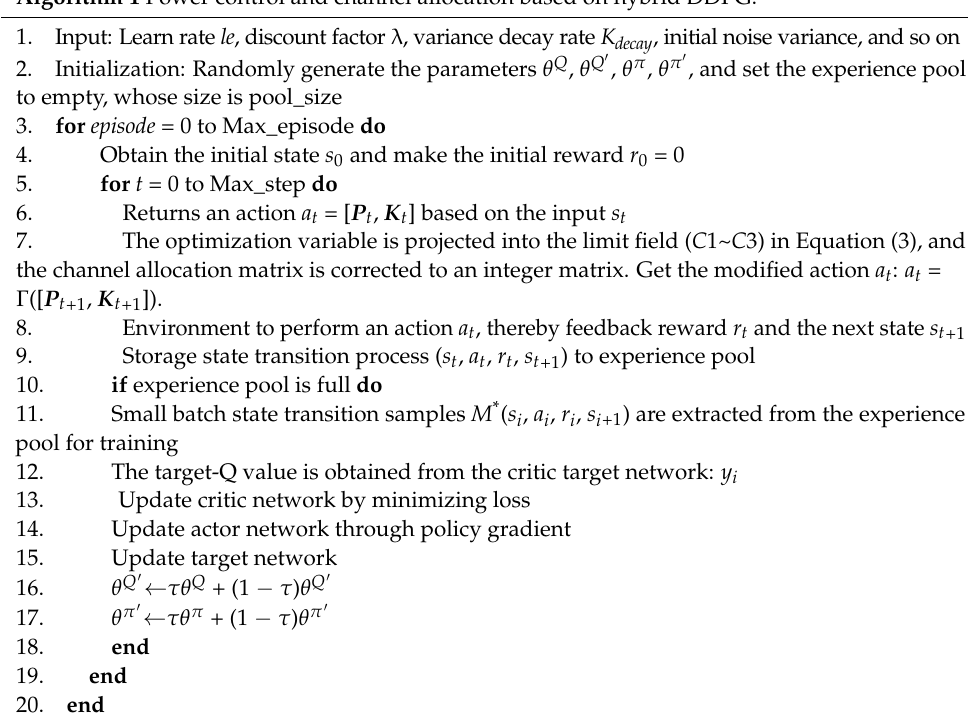
Figure 2. Flowchart diagram of the hybrid DDPG. Algorithm 1 Power control and channel allocation based on hybrid